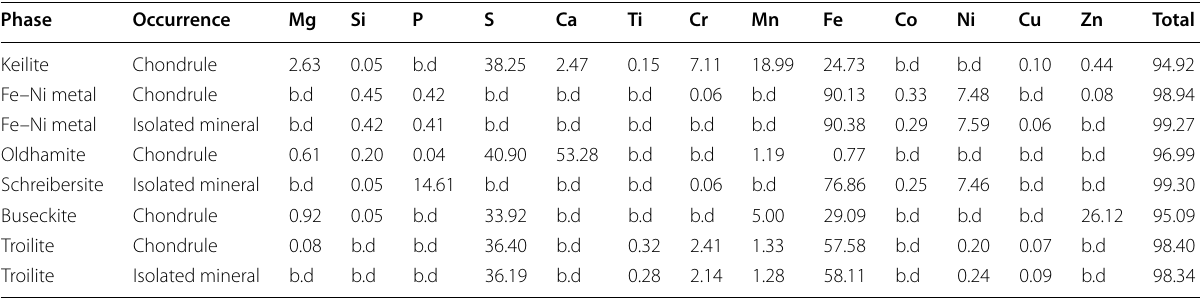
b.d.: below detection limits (3 s), 0.03 for Mg, Si, P, Ti, and Ca, 0.05 for S, Co, Ni, Cr, Mn, Fe, Zn, and